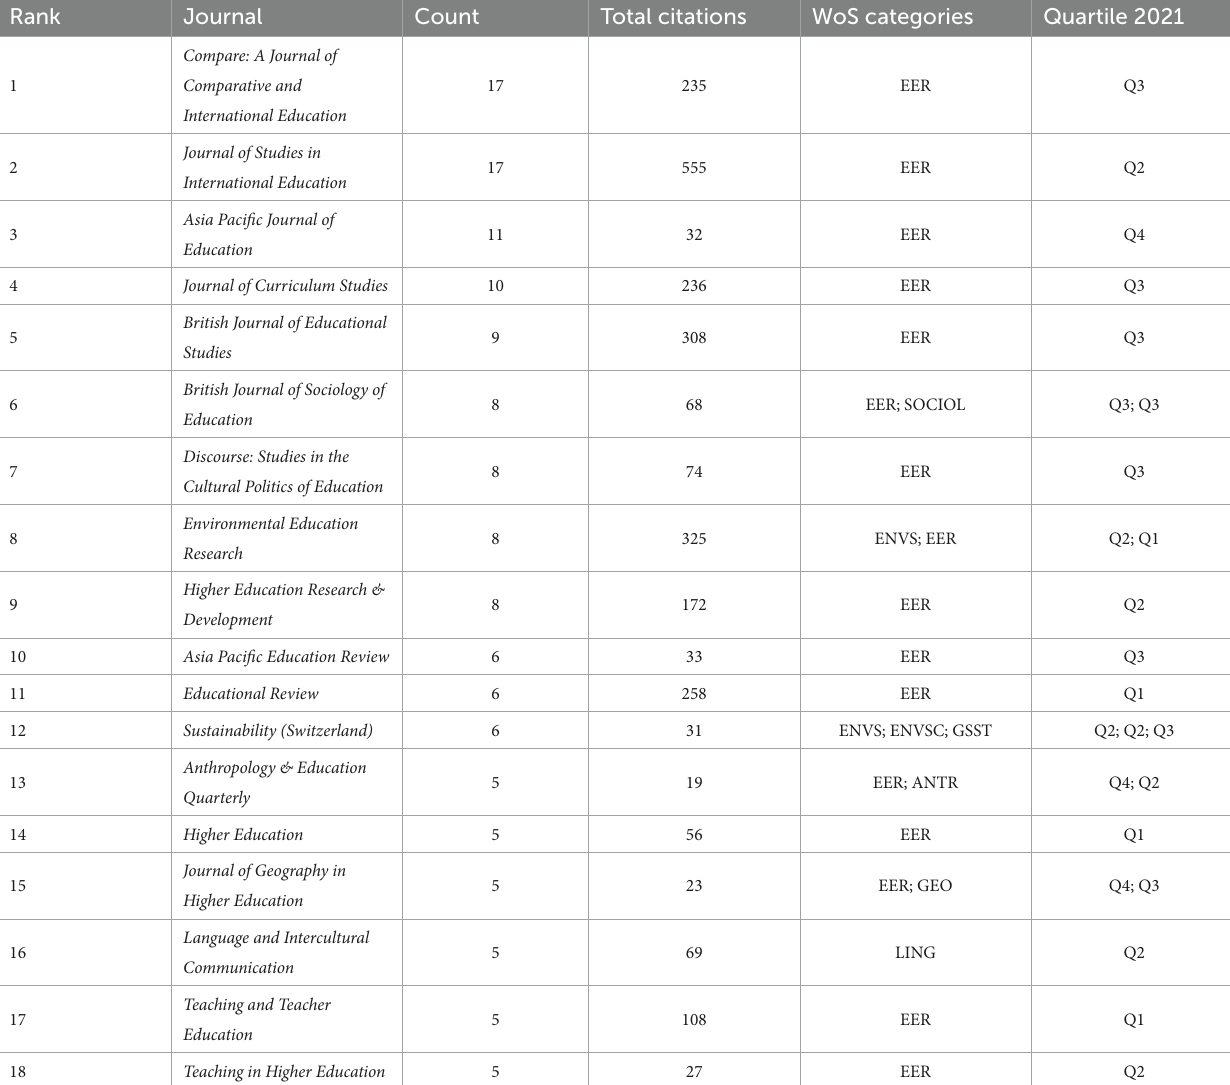
TABLE 2 The most productive journals that include GCE-related publications, indexed in the WoS (minimum five documents). Rank Journal Count Total citations WoS categories Quartile 2021